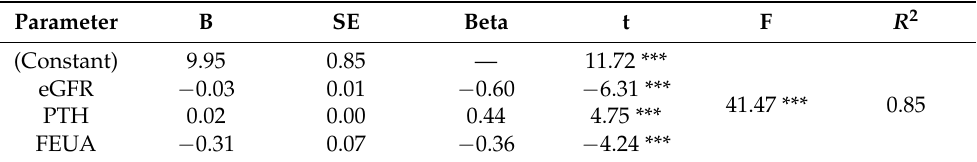
Table 4. Independent predictors of serum uric